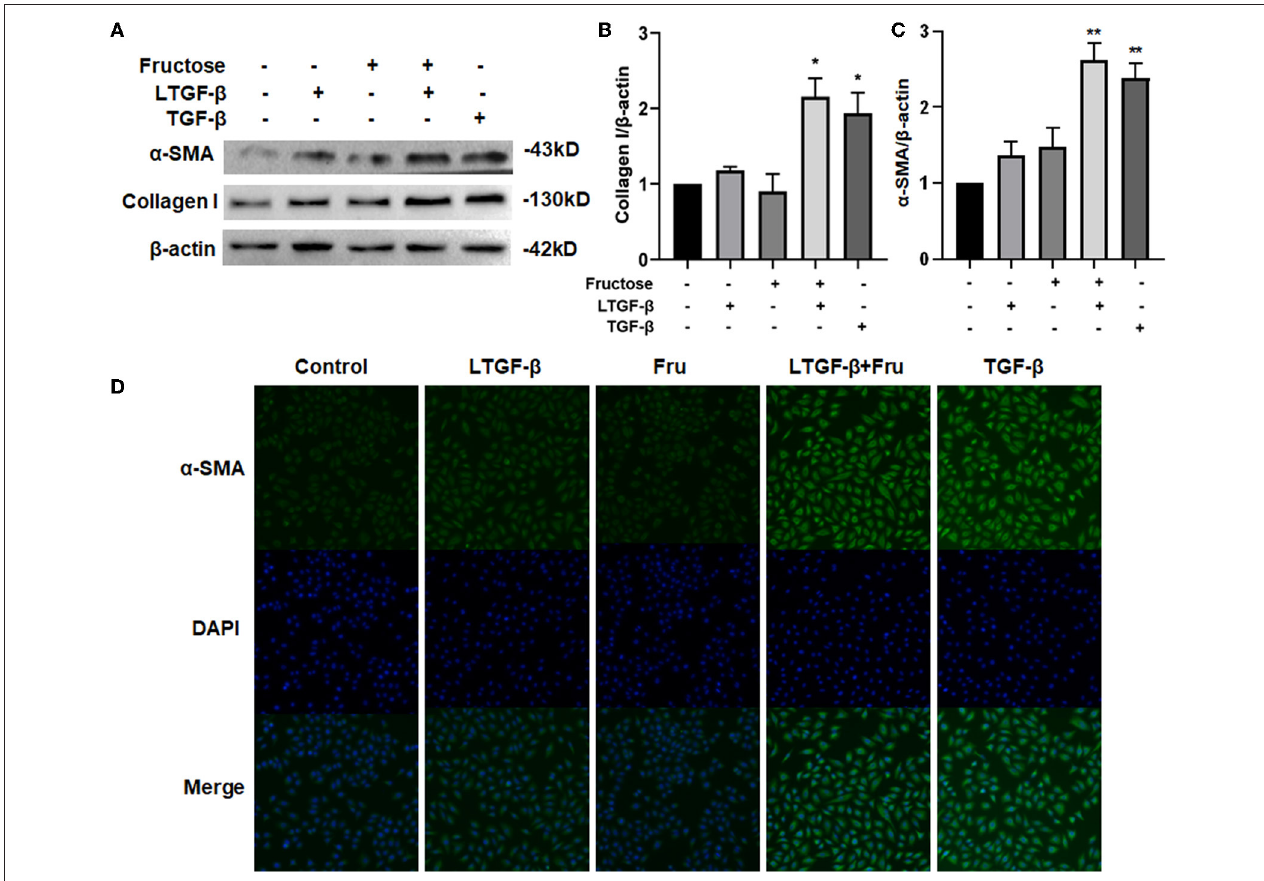
FIGURE 3 | Effect of fructose on fibrosis-related proteins in A549 cells induced by latent TGF- β 1. (A–C) Expression of collagen I (A,B) and α -SMA (A,C) in the lysates of A549 cells treated under the indicated condition was analyzed by Western blot. Representative gels were shown, and data were summarized from three independent experiments and analyzed using one-way ANOVA followed by Tukey’s test. The relative value was set as fold induction to the control set at 1, normalized to β -actin. (D) Additionally, the α -SMA expression was determined by immunofluorescence (200 × ). * p < 0.05, ** p < 0.01 vs. control group. Control, 0mM fructose; Fru, 10mM fructose; LTGF- β 1, latent TGF- β 1; LTGF- β 1 + Fru, latent TGF- β 1 + 10mM